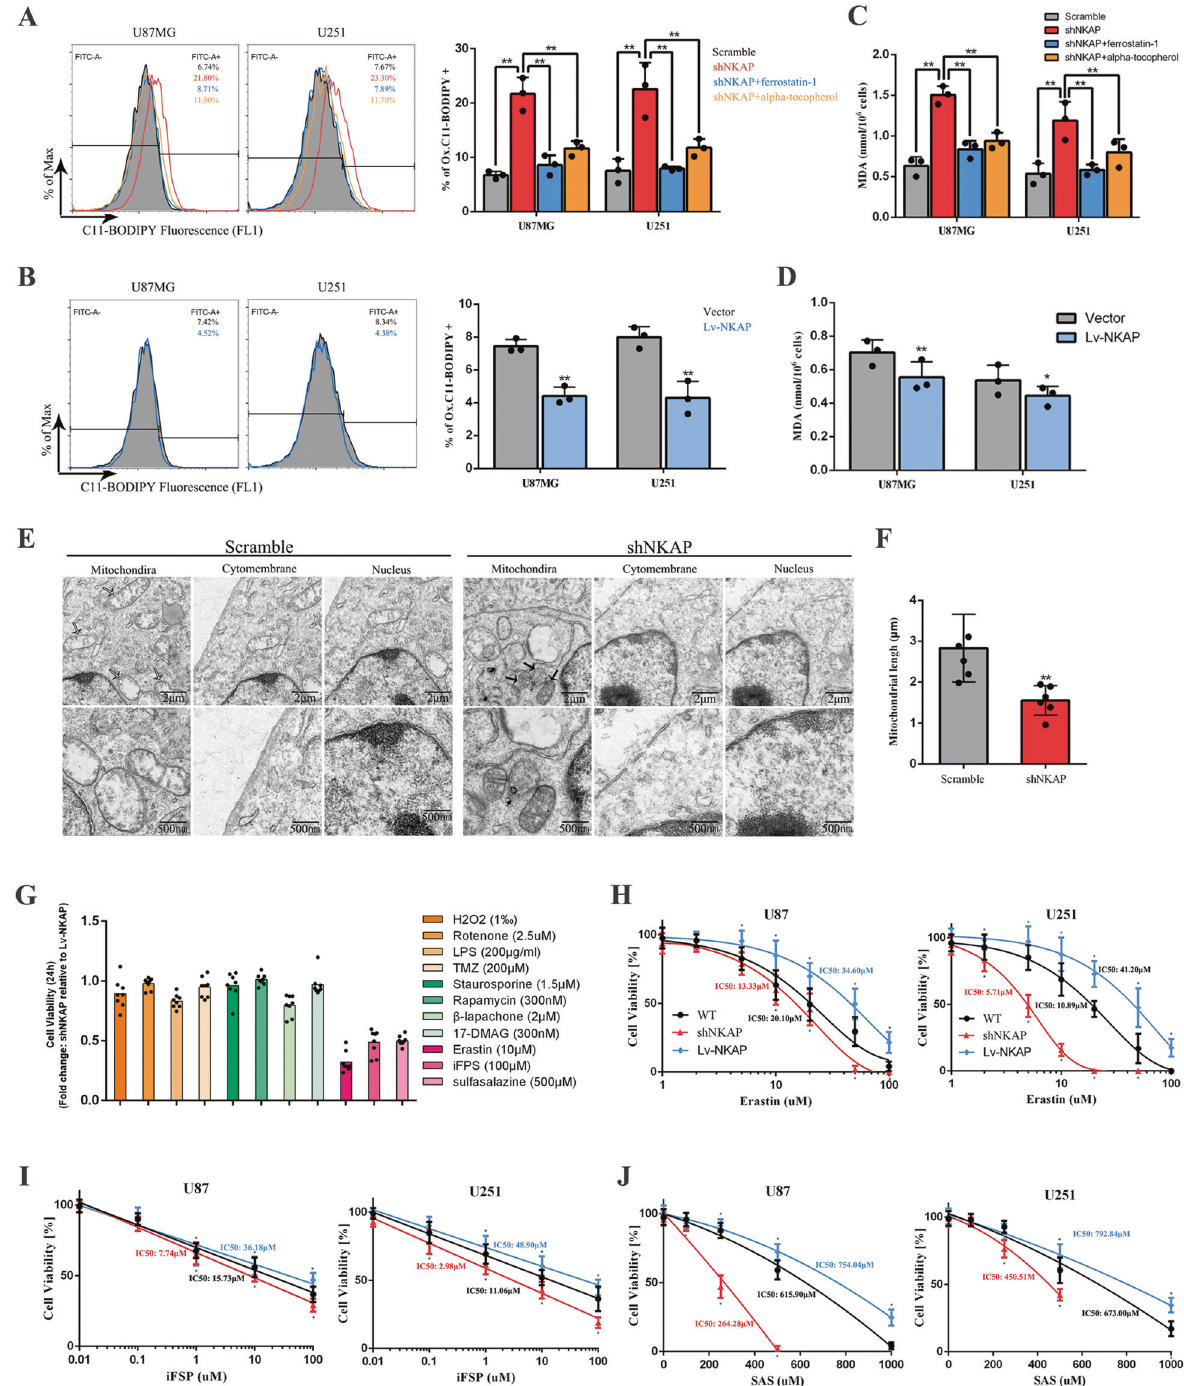
Fig. 2 NKAP knockdown induced cell death through ferroptosis. A Lipid peroxidation level in U87MG and U251 cells was in fl uenced by NKAP knockdown assessed by C11-BODIPY using fl ow cytometry immunolabelling in the absence or presence of 0.5 μ M ferrostatin-1 or 5 μ M alpha-tocopherol for 24 h. B Lipid peroxidation level in fl uenced by NKAP overexpression. C MDA level in fl uenced by NKAP knockdown in the absence or presence of 0.5 μ M ferrostatin-1 or 5 μ M alpha-tocopherol for 24 h. D MDA level in fl uenced by NKAP overexpression. E Transmission electron microscopy revealed the characteristics of NKAP knockdown U87MG cells. The white arrow indicated normal mitochondria. Black arrow indicated deeply stained, shrunken mitochondria. F The longest diameter of the mitochondria in the scramble ( n = 6) and shNKAP ( n = 6) group. G Effect of NKAP on the U87MG cell sensitivity to erastin (10 μ M), iFSP1 (100 μ M), SAS (500 μ M), rotenone (2.5 μ M), 17-DMAG (300 nM), staurosporine (1.5 μ M), TMZ (200 μ M), β -lapachone (2 μ M), H2O2 (1 ‰ ), LPS (200 μ g/ml), and rapamycin (300 nM). All drug treatments were for 24 h. H Cell viability of U87MG and U251 glioma cells when grown in 1, 2, 5, 10, 20, 50, and 100 μ M erastin for 24 h. I Cell viability when grown in 0.01, 0.1, 1, 10, and 100 μ M iFSP1 for 24 h. J Cell viability when grown in 0, 100, 250, 500, and 1000 μ M SAS for 24 h. All bars show mean ± SD of three independent experiments. * P < 0.05, ** P < 0.01. Cell Death and Disease (2022)